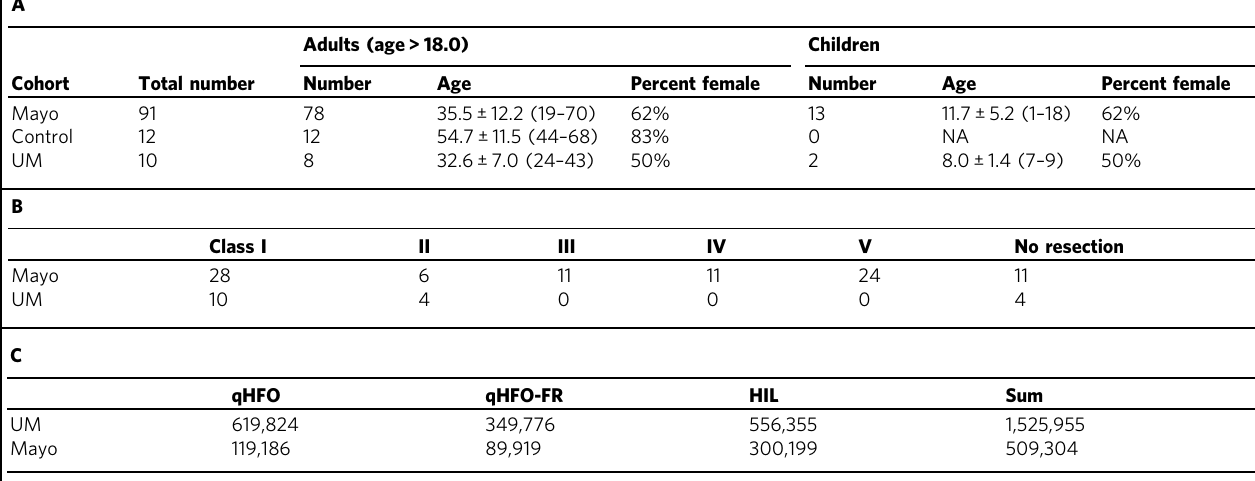
A:Demographicdataarebasedonavailableclinicalreports.Ageisattimeofelectrodeimplantation,andwasnotavailableforallpatients.Ageislistedasmeanplusorminusthestandarddeviation,with the minimum and maximum values listed in parentheses B: The patient ILAE outcome class from each center shows that the Mayo cohort had many patients with poor outcome, so it is dif fi cult to compare HFO results between the two centers C: The number of detected HFOs from each center using each of the three detection schemes is shown. Data from UM include all NREM sleep during the whole hospitalization, and from Mayo